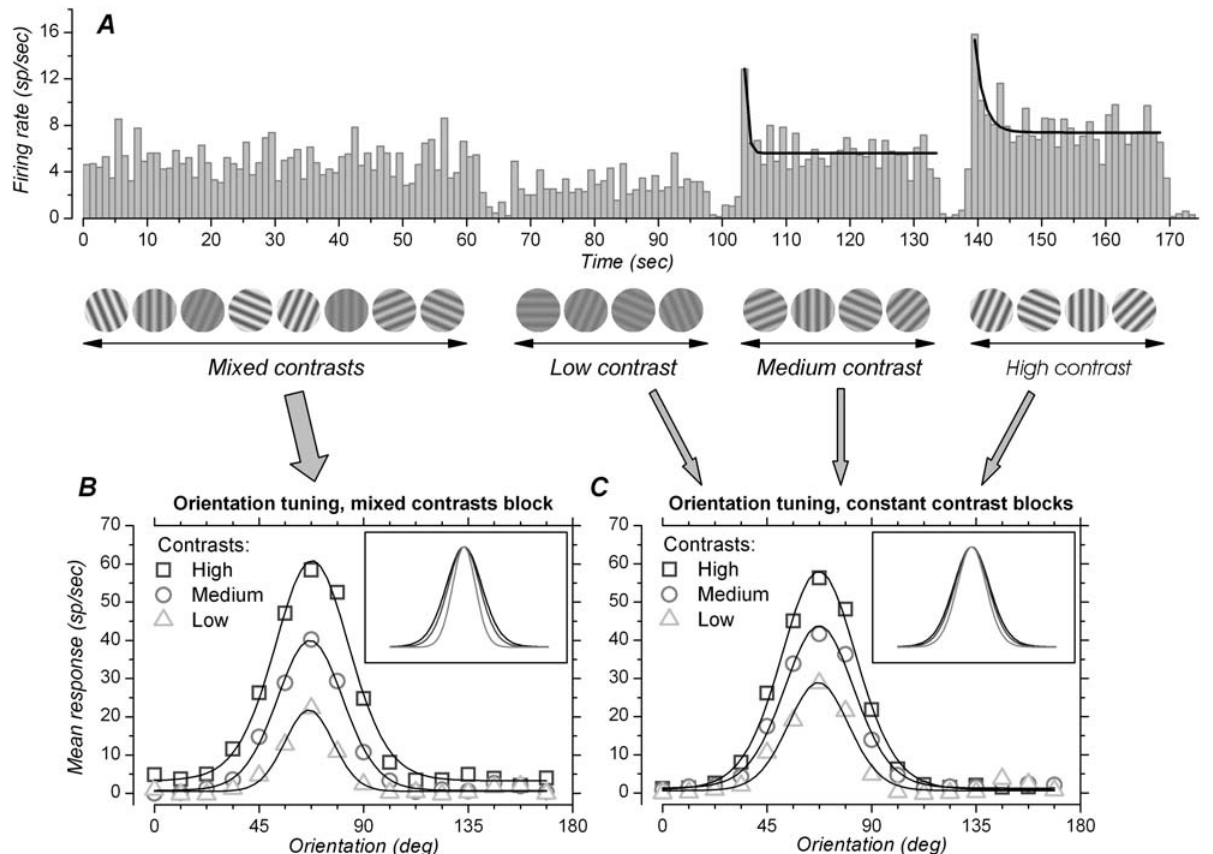
Figure 1. Protocol and orientation tuning with different contrasts, with and without matched adaptation, example. A. PSTH (bin width 1 sec) of the spiking response obtained with the four blocks of stimuli repeated 12 times in a marmoset V1 cell. Some of the grating stimuli, varying in contrast and orientation, are sketched below the PSTH. Sixteen orientations (from 0 to 168.75 deg, 11.25 deg steps) and 3 contrasts (16, 32 and 64% for this neuron) were randomly presented during the ‘‘mixed contrasts’’ block. Each grating presentation was 0.2 sec long, which is too short to allow for contrast adaptation. Since contrast varies at high rate, adaptation can only occur for a contrast level which is the mean of the different contrasts presented: there is a mismatch between the stimulus contrast presented at a particular time, and the contrast to which the cell is adapted. For the second, third and fourth stimulation blocks, the 16 orientations were still randomly presented, but only one contrast at a time was used: either low, medium or high. The duration of each block ( . 30 sec in this example) was long enough to allow for adaptation to each of the contrasts. The stimulus contrast presented at a particular time then matched the contrast to which the cell was adapted. Black lines on medium and high contrast responses correspond to the exponential decay fitted to the data. The time constant of adaptation was 0.54 sec with the medium contrast and 1.42 sec with the high contrast. There was no significant adaptation with the low contrast. B. Orientation tuning for data obtained during the mixed contrasts block. Symbols correspond to the mean firing rate for each orientation and contrast, and the lines correspond to the von Mises equation fitted to the orientation-response data. Inset shows fitted lines normalized to the same preferred orientation and to the same height, to facilitate comparison of tuning width. HWHH were 19.0, 16.8 and 12.2 deg for the tuning curves obtained with high, medium and low contrast stimuli, respectively. C. As in B, but for responses obtained after adaptation to either low, medium or high contrast. Spikes outside steady state adaptation, considered to begin at a time corresponding to 3 times the adaptation time constant, were not included in the calculation. HWHH were 19.2, 17.9 and 15.4 deg for the tuning curves obtained with the high, medium and low contrast stimuli, respectively. In this cell, adaptation led to a compression of the range of tuning widths and response amplitudes obtained with the different contrasts. The discrepancy between the spike rates in the PSTH in A and the orientation tuning curves in B and C is due to the fact that interstimulus intervals and responses to non-preferred orientations are included in the average for the long time-scale